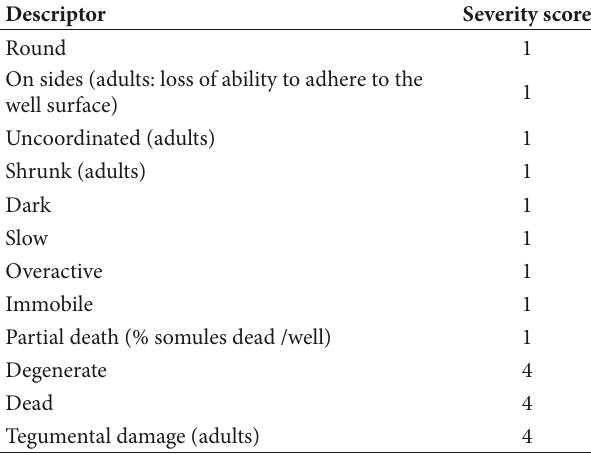
Table 1: Descriptors and corresponding severity scores for the effect of extracts and fractions of E. ivorense on S. mansoni . Unless otherwise indicated, the descriptors employed are common to both somules and adults .